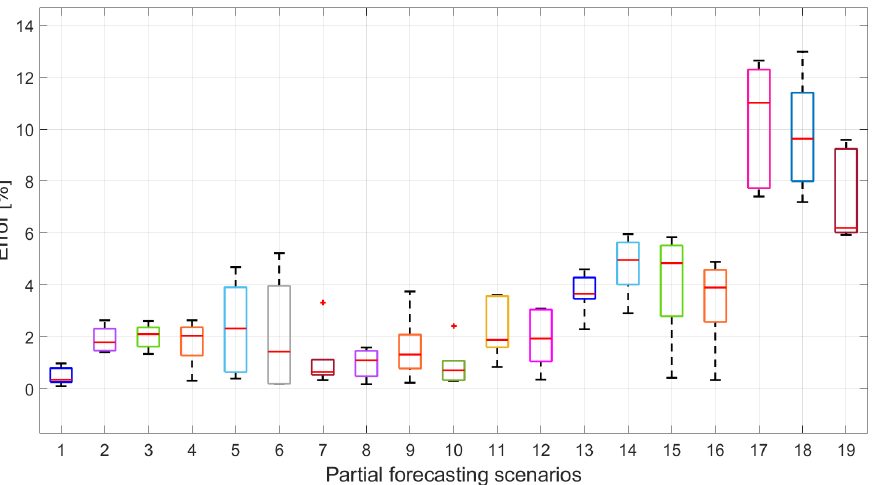
Figure 12. Error analysis for each forecasting